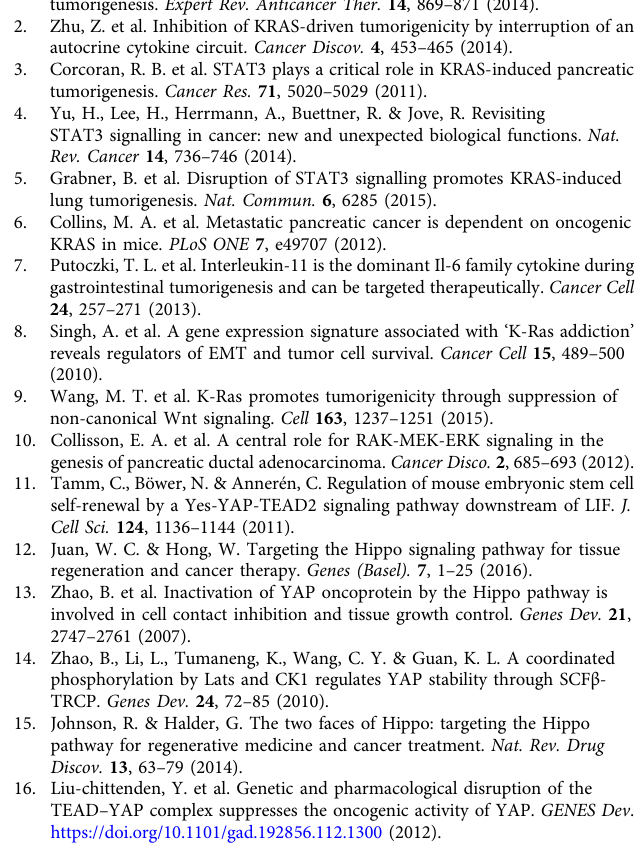
Fig. 5 LIF suppresses the Hippo-signaling pathway in human pancreatic cancer cells. a Representative HOPFlash luciferase assay showing YAP/TAZ-TEAD transcriptional activity in human pancreatic cancer cells receiving IL-6 or LIF at 100 ng/mL ( N = 3, ** P < 0.01, *** P < 0.001, **** P < 0.0001). b (Left panel) Representative western blots showing inducible knockdown of LIF in Panc1.0 by using two different hairpin sequences. (Right panel) Representative HOPFlash luciferase assay showing YAP/TAZ-TEAD transcriptional activity in Panc1.0 cells, which express inducible shRNA targeting human LIF ( N = 3, ** P < 0.01). Error bars from ( a, b ) represent the standard deviation and P -value was generated by t -test. c Western blots showing subcellular (nuclear) localization of total YAP in Panc1.0 cell line which express inducible shRNA against human LIF. d Representative western blots showing protein